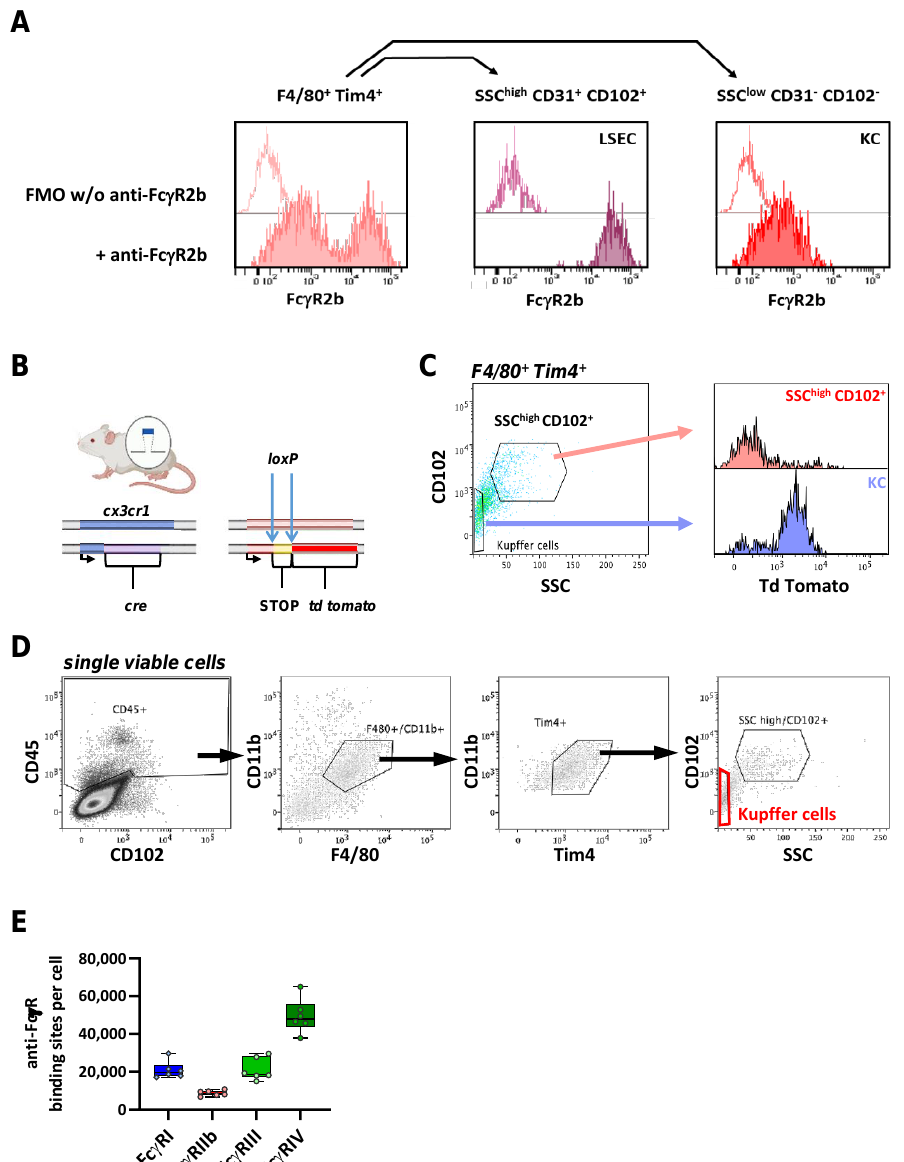
Figure 6. Characterization of Fc γ R expression on hepatic Kupffer cells. ( A ) Depicted is the fluorescence of F4/80 Tim4-double-positive liver cells with or without anti-Fc γ RIIb, respectively. Among these F4/80 + Tim4 + cells, Fc γ RIIb expression was analyzed in populations with either a high side scatter (SSC) and the presence of endothelial markers CD31 and CD102 (medium panel) or a low side scatter and the absence of CD31 and CD103 (right panel). ( B ) Genetic characteristics of BL6 Rosa26- td tomato x BL6 cx3cr1-cre mice. In these mice, one allele of the CX3CR1 locus mice encodes a Cre recombinase